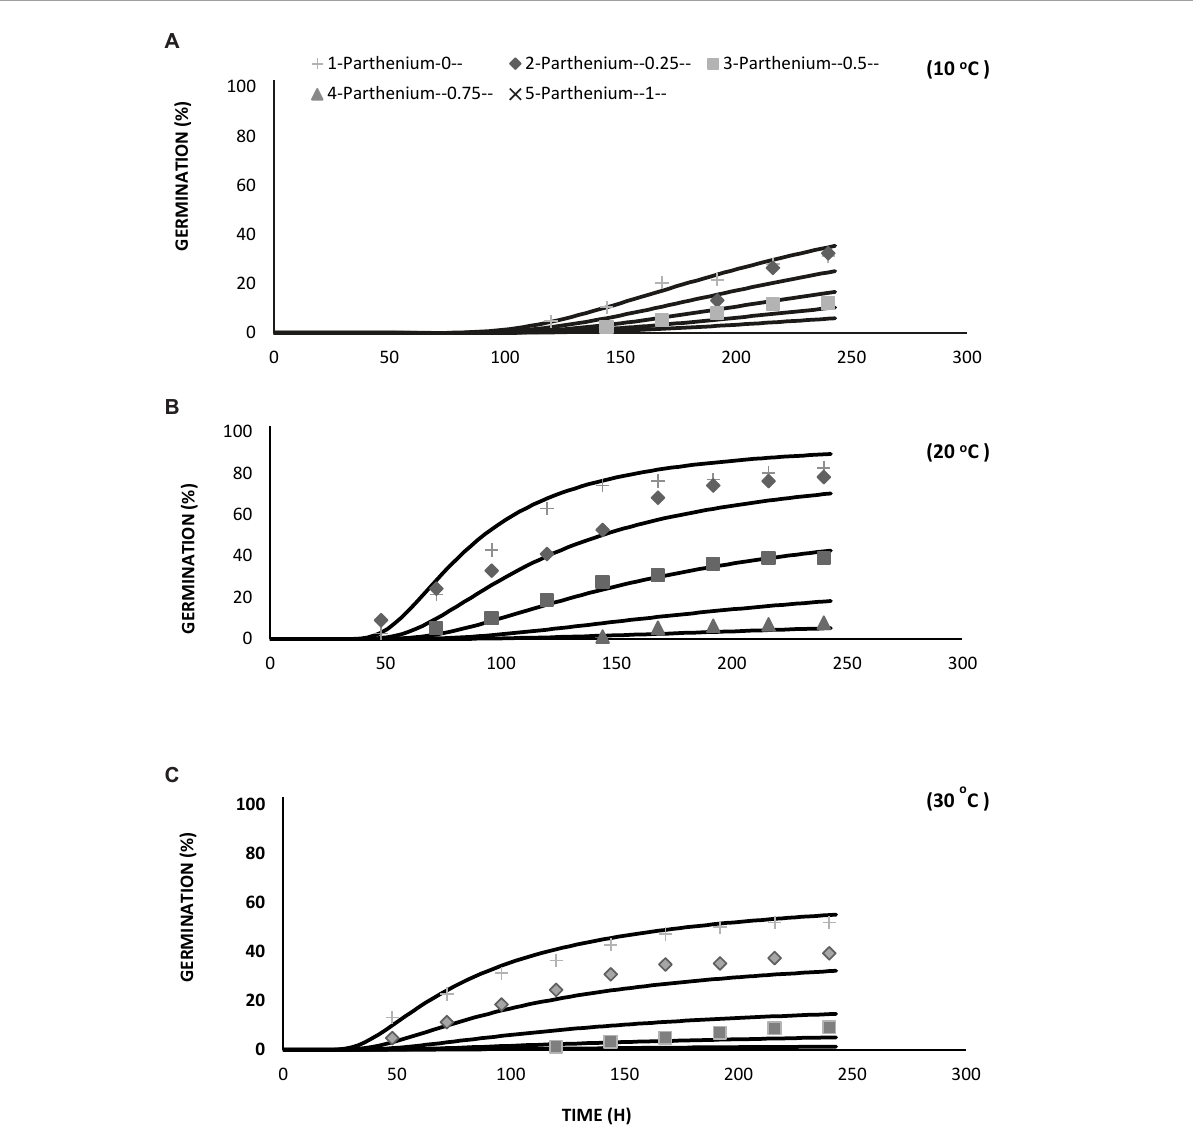
FIGURE5 Germination curve of Parthenium hysterophorus at different levels of water potentials by using hydrotime model under controlled environment at temperatures of (A) 10, (B) 20, and (C) 30 ◦